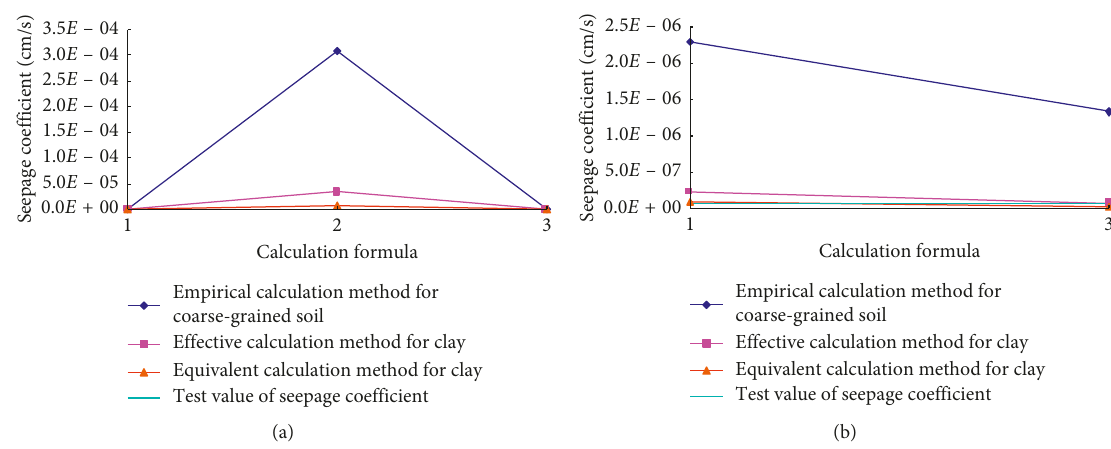
Figure 8: Seepage coefficients of coastal saline soil from Kuwait under (a) formulas (1)–(3) and (b) formulas (1) and (3).